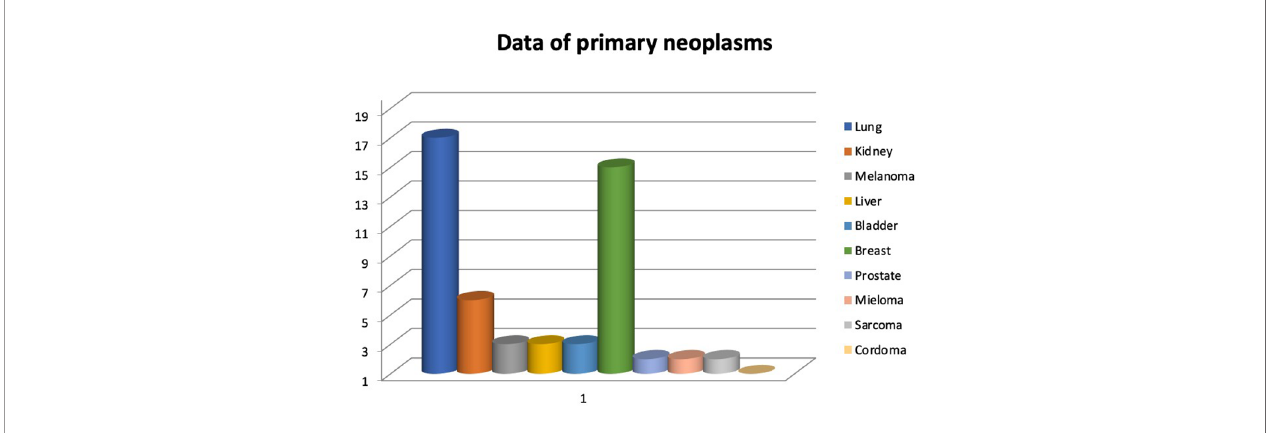
FIGURE 1 | Frequency of primary